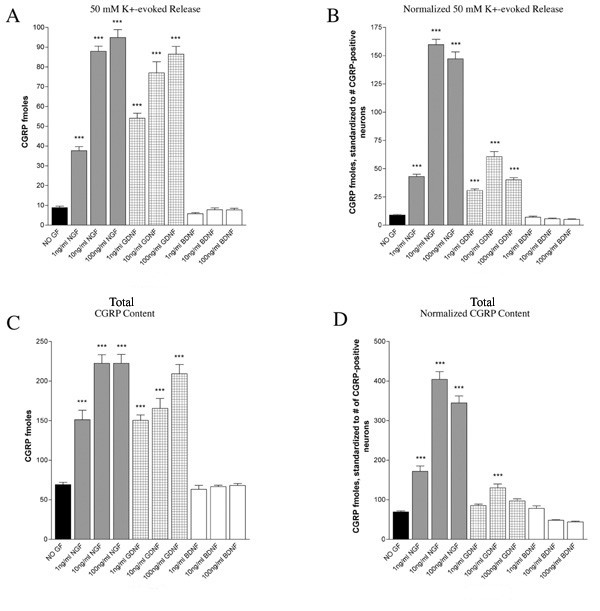
50 mM K+ -evoked CGRP release and total CGRP content in TG cultures. Panel A illustrates the effect of growth factor treatment on 50 mM K+ -evoked CGRP release, while panel B shows the data standardized to the number of CGRP-positive neurons per condition as a proportion of the no growth factor-treated cultures. Panel C shows total CGRP content by growth factor treatment, and again, panel D shows this data standardized to CGRP-positive neurons, as stated above (*** p < 0.001, n = 6).